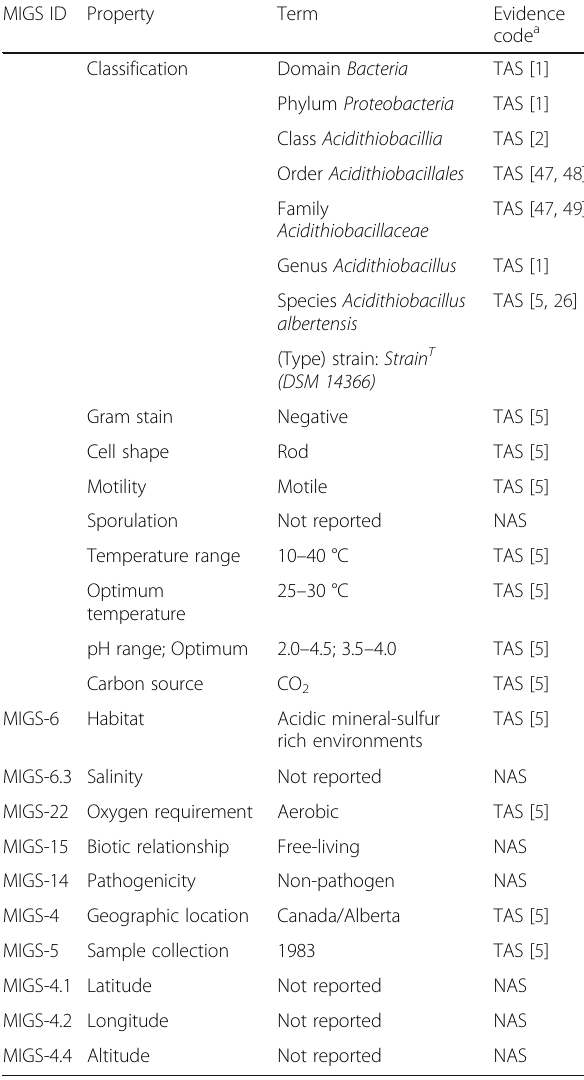
Table 1 Classification and general features of A.